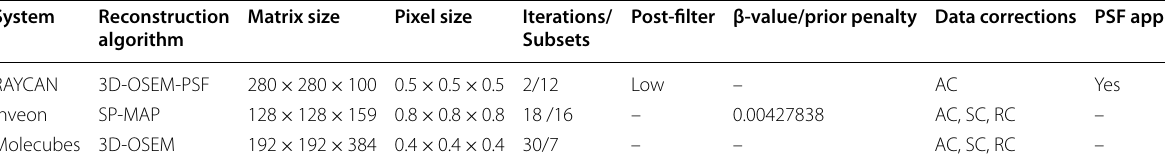
AC attenuation correction, SC Scatter correction, RC randoms correction